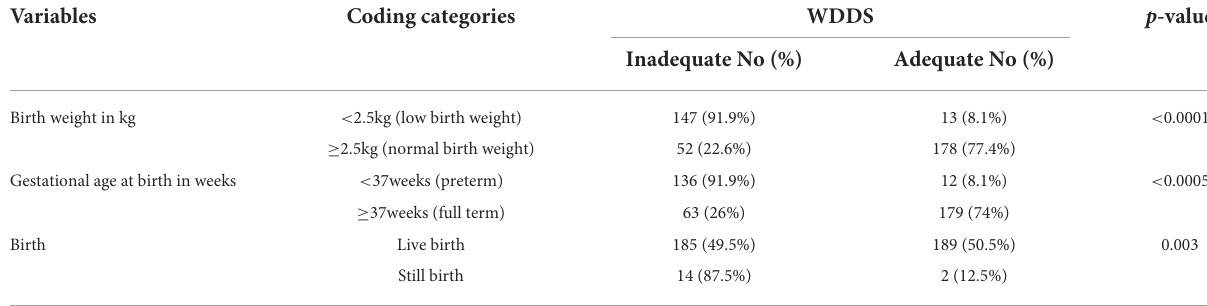
TABLE 4 Pregnancy outcomes of the study participants in the east Gojjam zone, northwest Ethiopia,